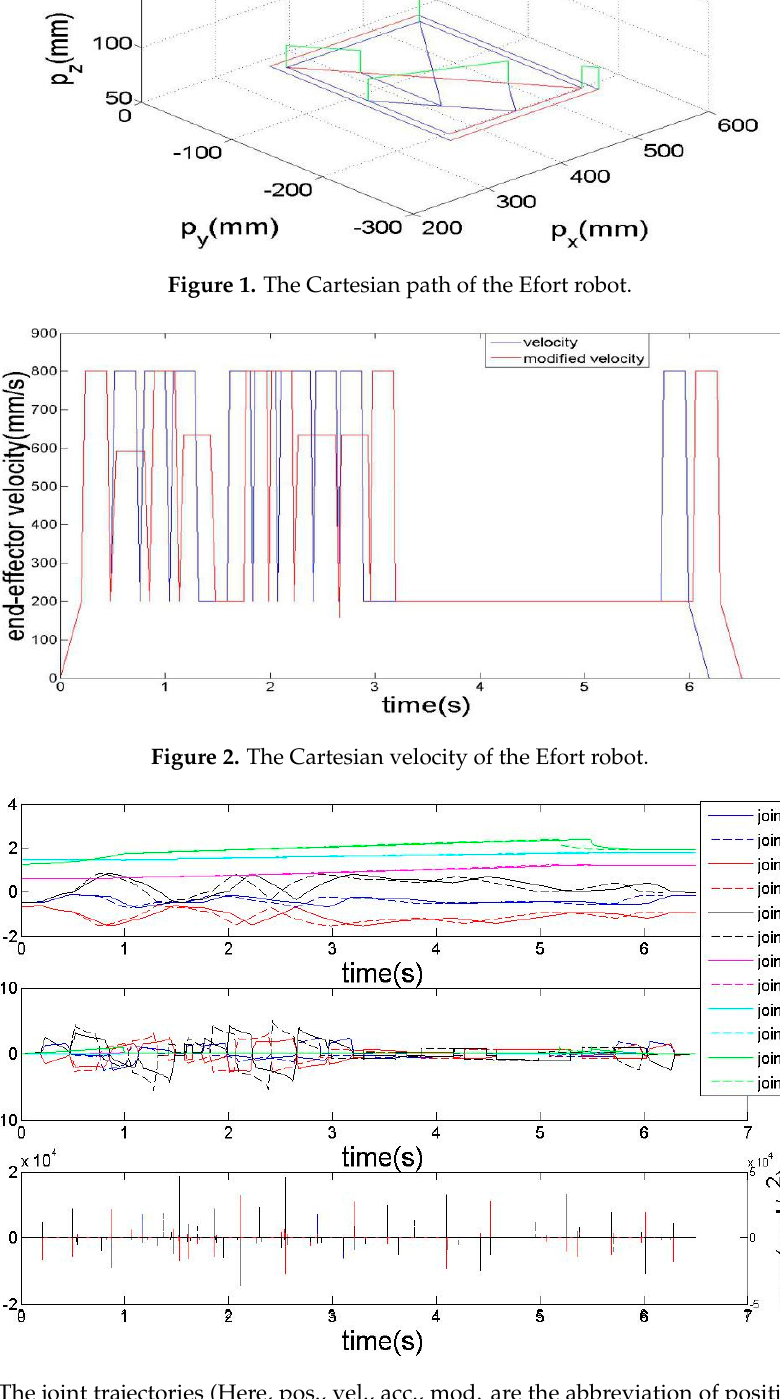
Figure 3. The joint trajectories.(Here, pos. , vel., acc., mod. are the abbreviation of position, velocity, acceleration and modified, respectively.).